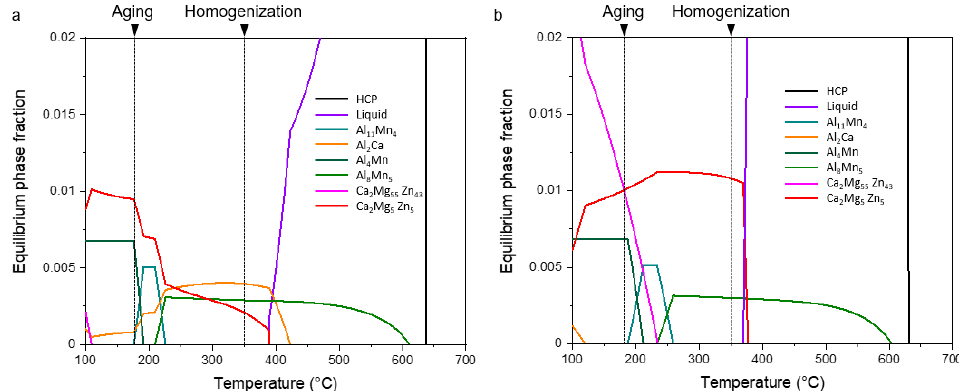
Figure 4. Calculated equilibrium phase fractions of ( a ) ZAXM2100 and ( b ) ZAXM4100 alloys calcu- lated by thermodynamic software Pandat.